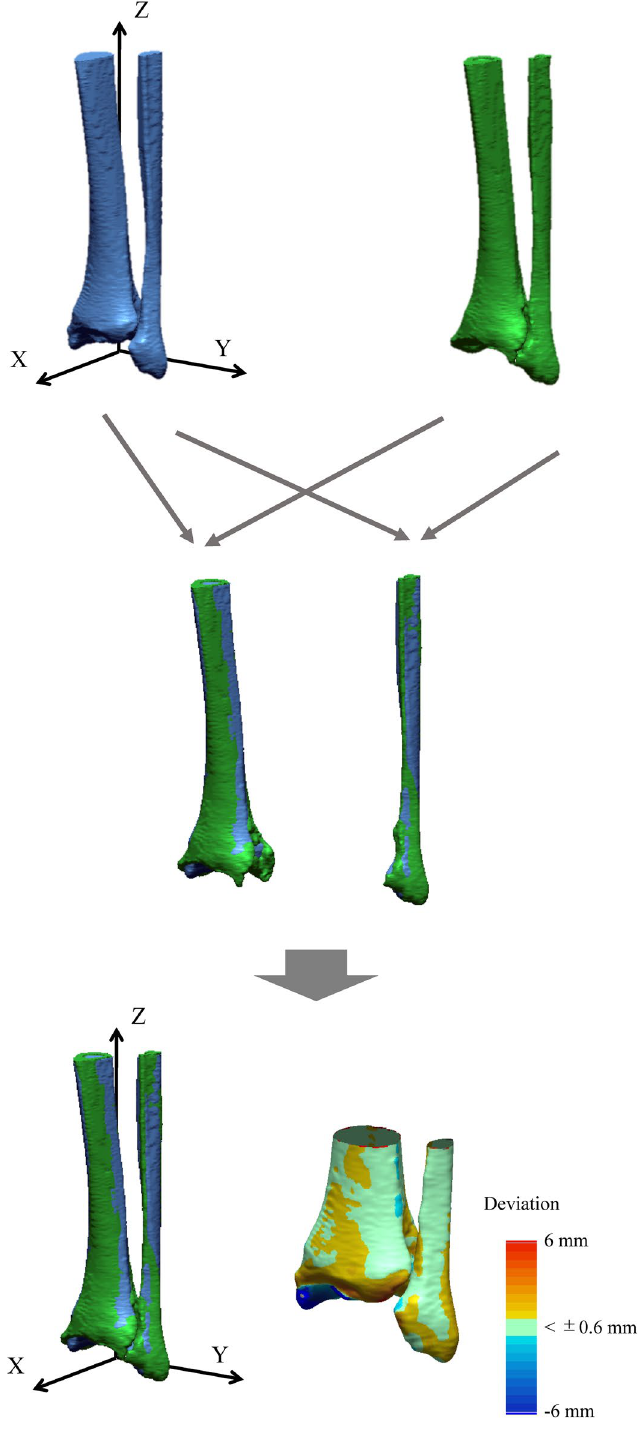
Figure 6. Left–right comparisons of the tibia and fibula in unilateral varus ankle OA. Mirror image models are created for the right-side specimens, and the osteoarthritic tibia and fibula models (green) are respectively registered to the opposite non-OA tibia and fibula models (blue) via an iterative closest point algorithm. The surface deviation is calculated as the distance between the two surfaces along the surface normal direction of the non-OA surface. The red and blue colors are deviations of the osteoarthritic surface outside and inside of the non-OA